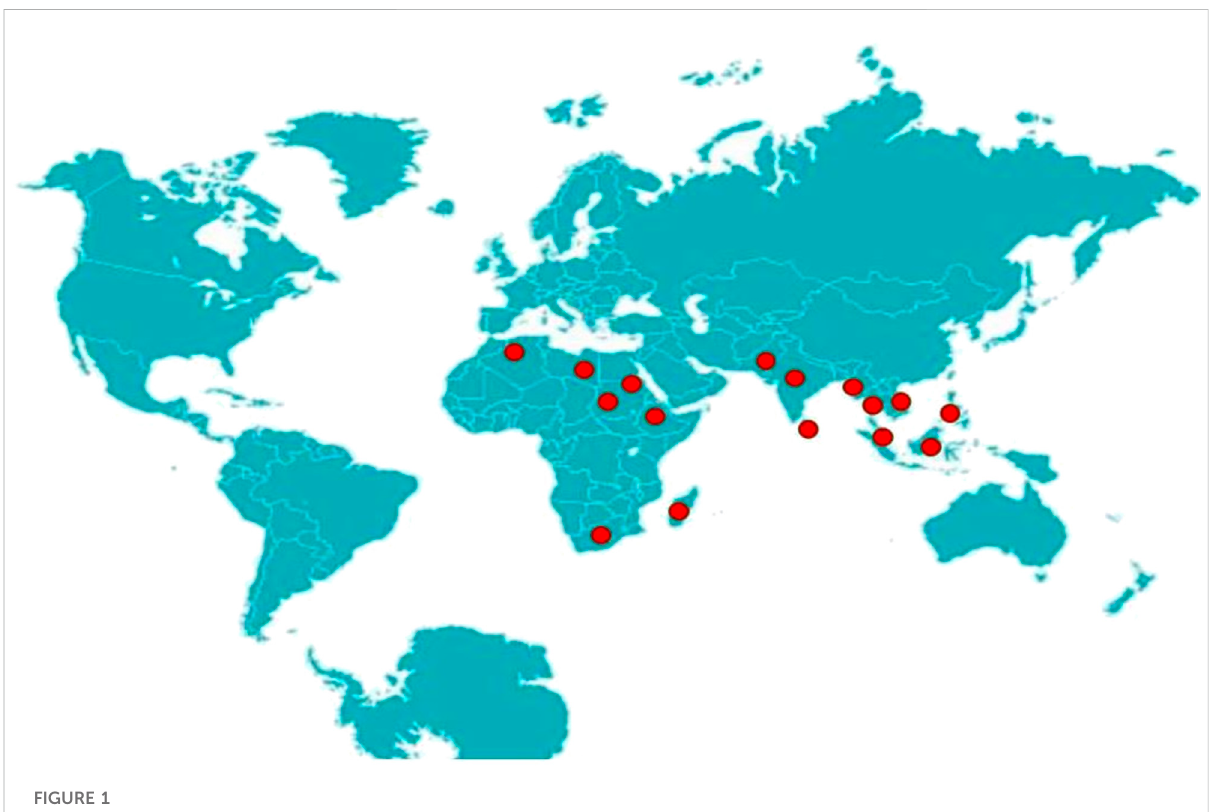
FIGURE 1 Geographical distribution of P. globosa.